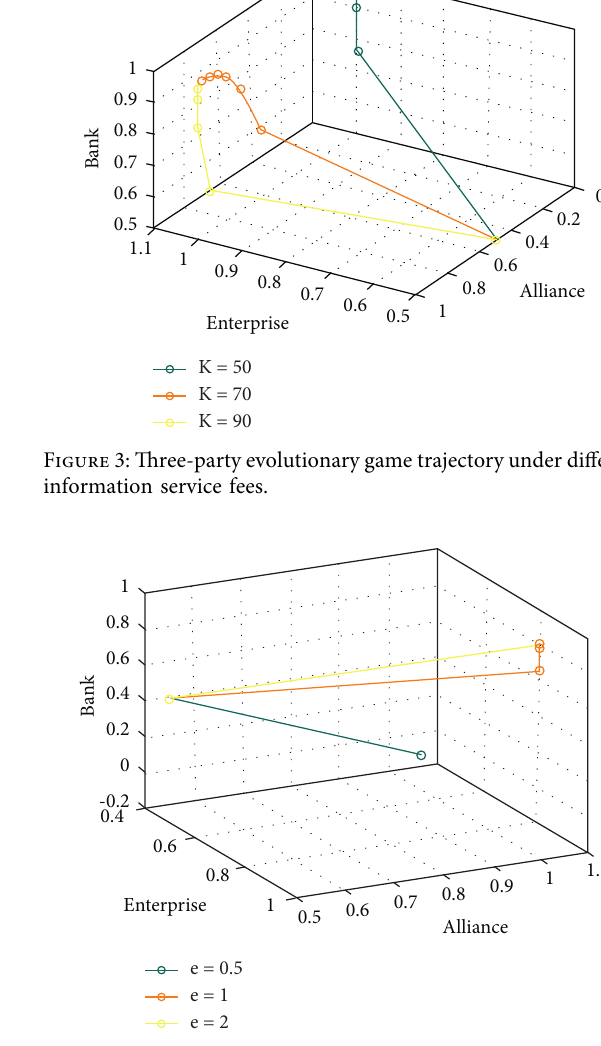
Figure 4: The trajectory of the three-party evolutionary game under different realization rates of